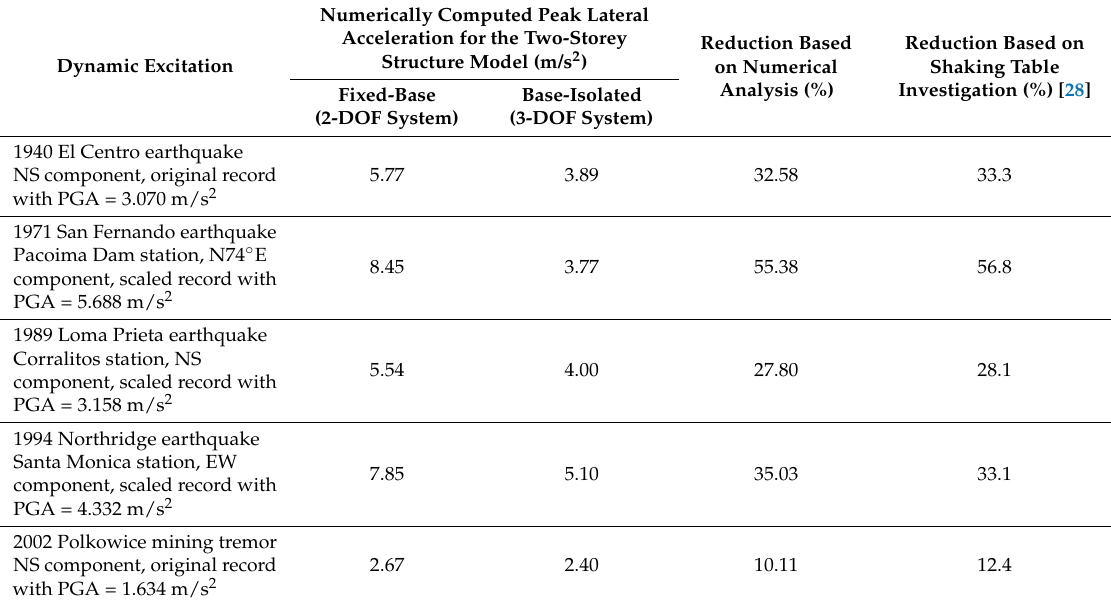
Table 4. Results of the seismic tests for the two-storey structure